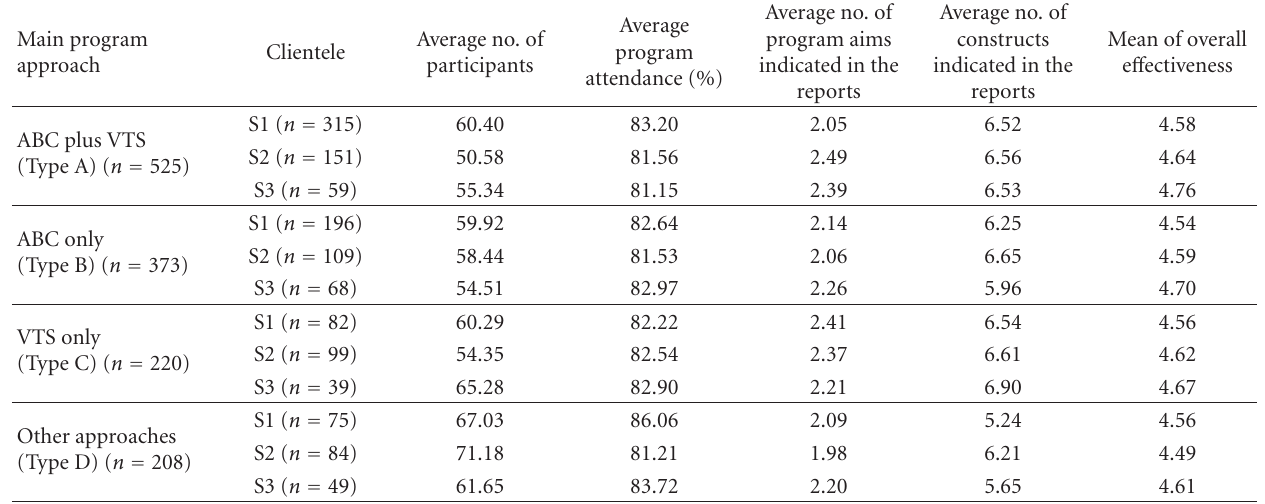
Table 2: Summary of the characteristics and e ff ectiveness of the Tier 2 program.